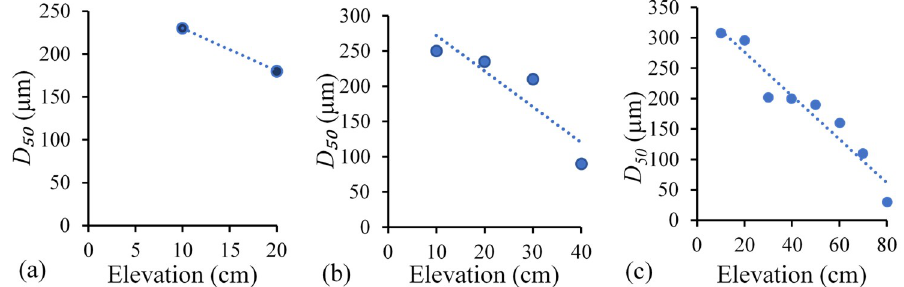
Figure 6. Variation of the D 50 (size of particles 50% passing) along the height of settled backfill for different backfilled columns: ( a ) 20 cm, ( b ) 40 cm, and ( c ) 80 cm; the elevation measured from the bottom of the columns.